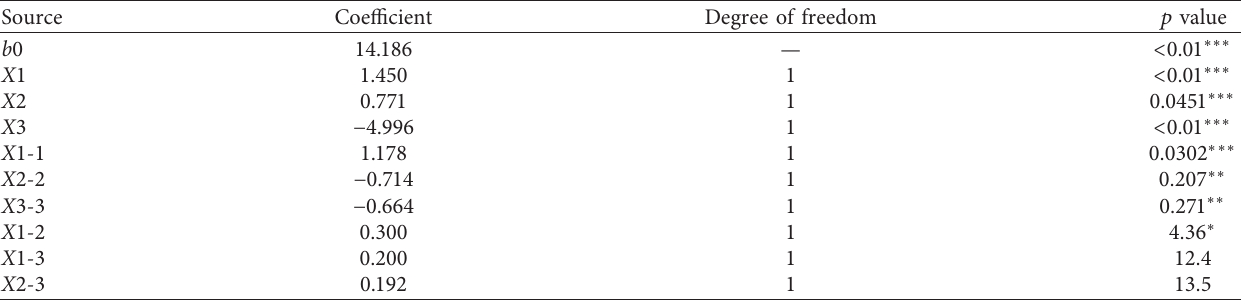
Table 4: Effect estimation, statistical significance, and regression coefficient estimates for phenolic compounds extraction from Z. mays hairs.